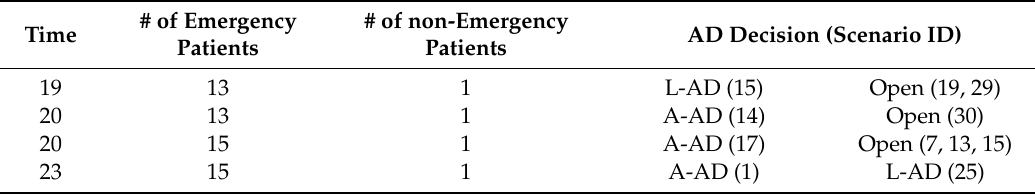
Table 6. Case of AD decisions made at hospital 1 in the centralized optimization model. L-AD, low severity AD; A-AD, all